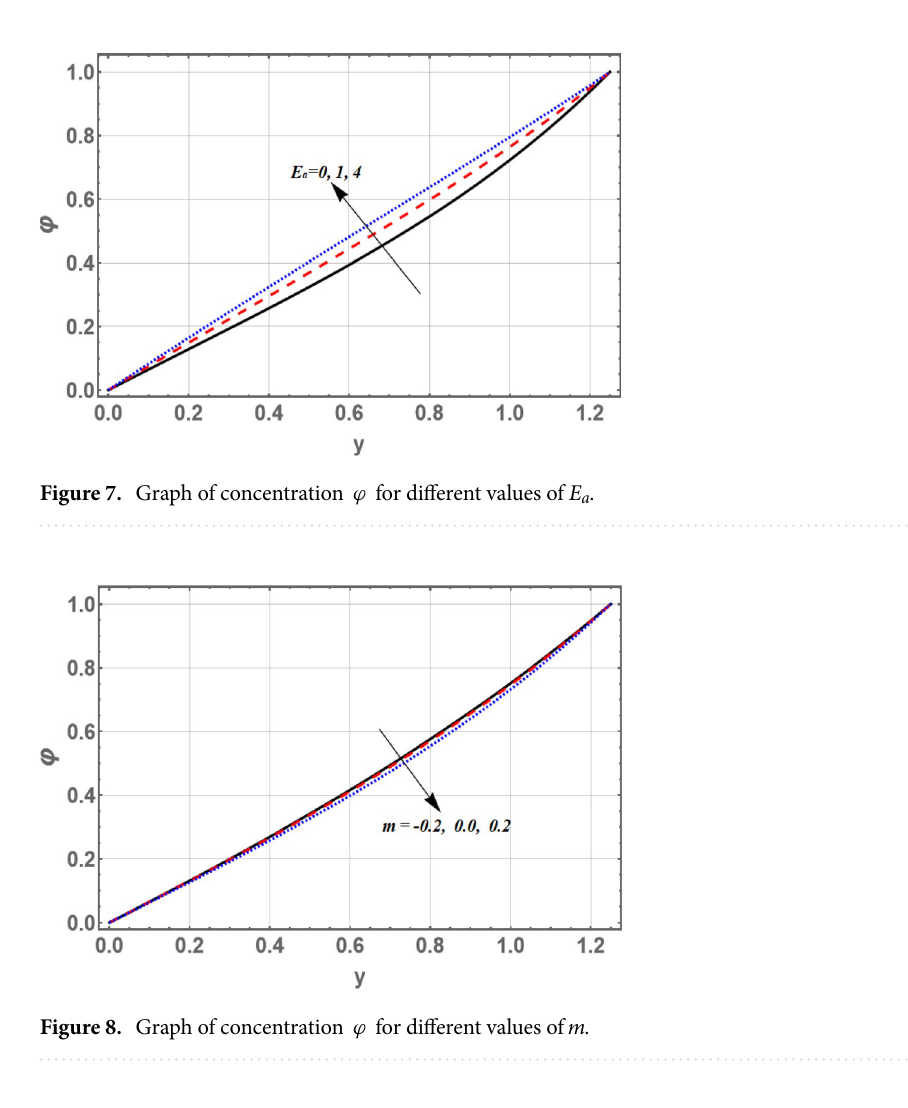
Figure 6. Graph of temperature θ for different values of ξ .